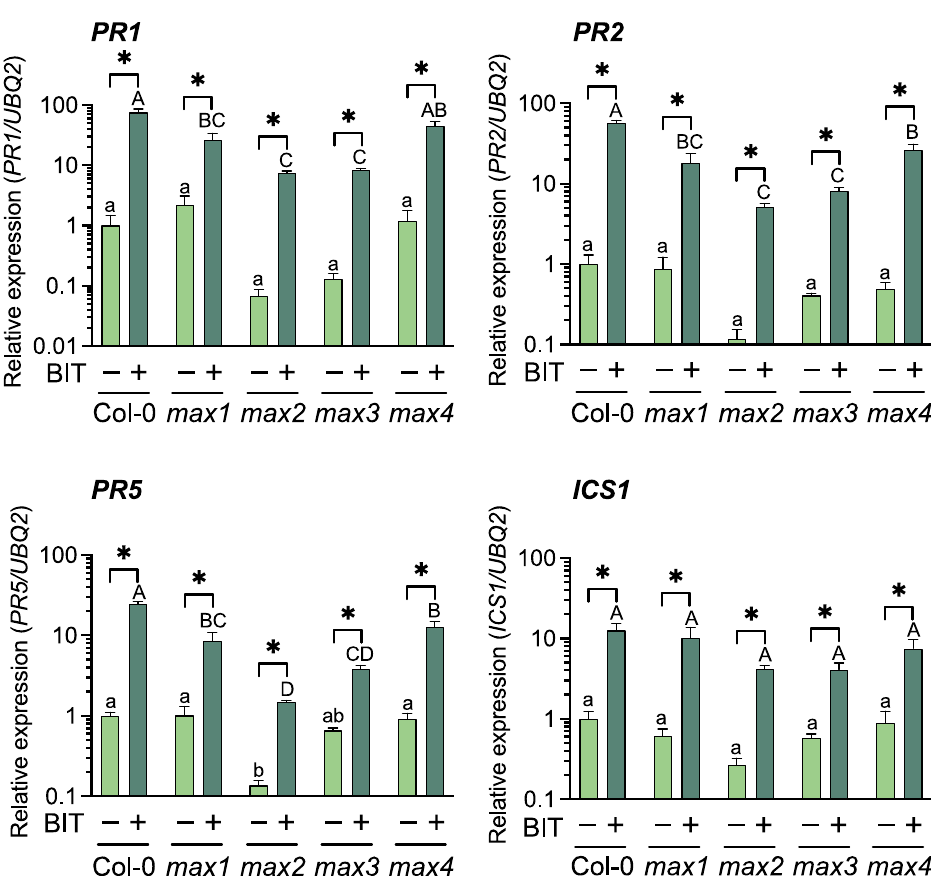
Figure 2. Expression of defense-related genes in BIT-treated plants. Leaves of three-week-old plants were sprayed with water (control) (–) or 1 mM BIT (+) and collected after 3 d. Transcript levels were normalized using the expression of UBQ2 (At2g36170) in the same samples. Relative mRNA levels among treatments are presented. Values are means ± SE ( n = 3). Significant differences between the control and BIT-treated plants are indicated by * (unpaired t -test, p < 0.05). Different letters indicate significant differences between accessions of the same treatment (Tukey’s multiple comparison test, p < 0.05).